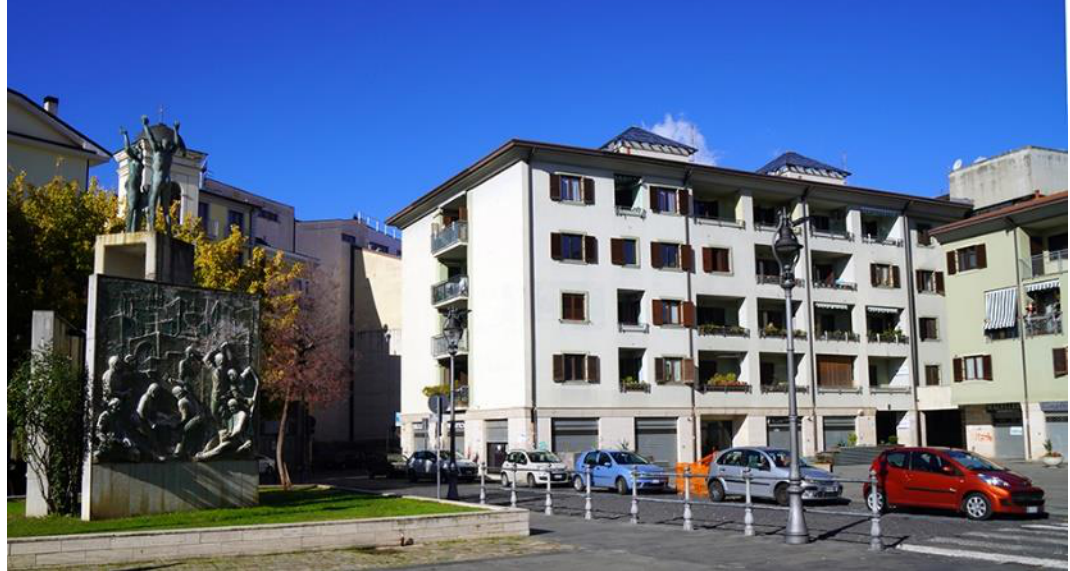
Figure 119. Avellino: “Piazza del Popolo” today completely reconstructed (photos by